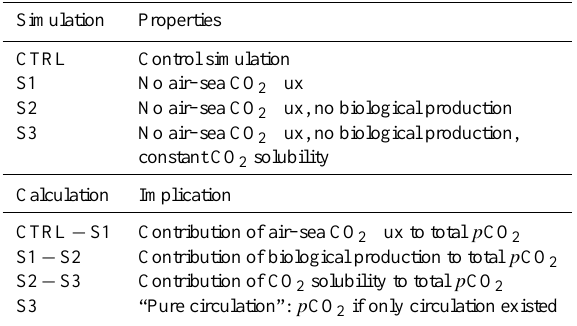
Table 2. Summary of the sensitivity studies used to determine the contributions of air–sea CO 2 flux, biological production, CO 2 sol- ubility and circulation to total p CO 2 from the control